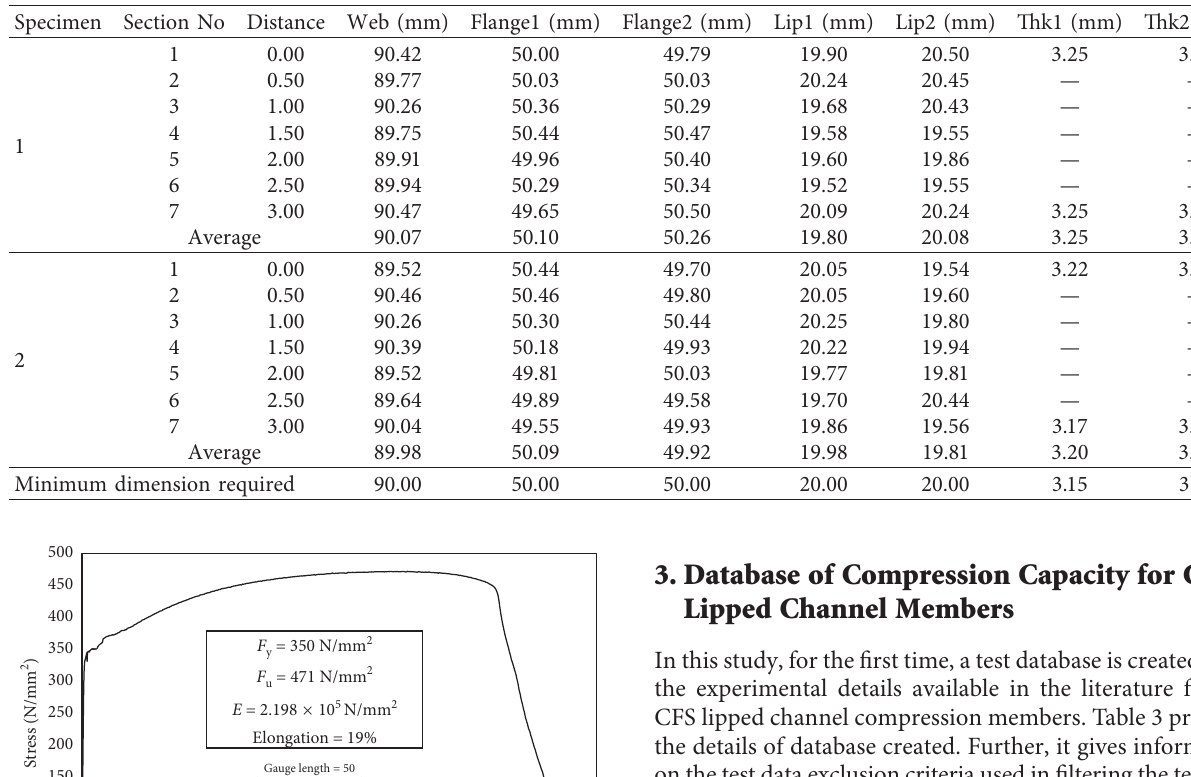
Table 1: Dimension measurement details of two number of CFS lipped channel specimens.